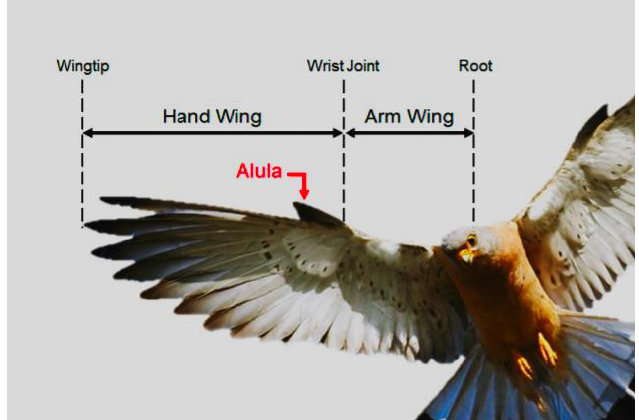
Figure 19. A deployed alula on the wing of the bird [71].